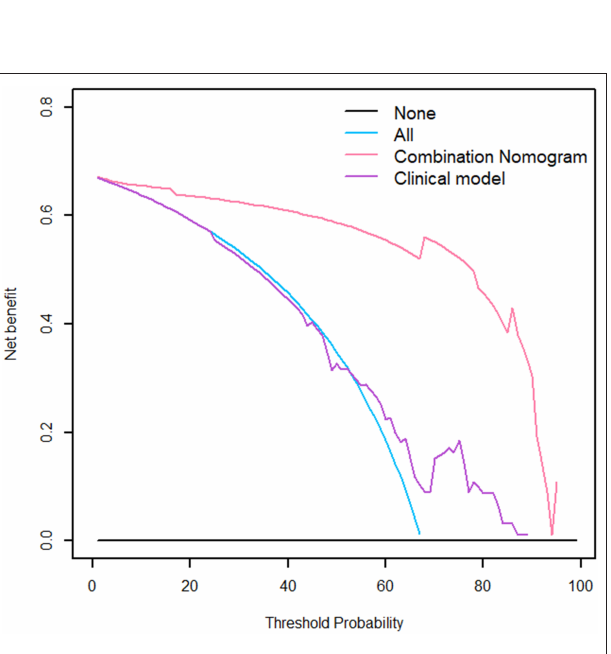
FIGURE 6 | The decision curve of the